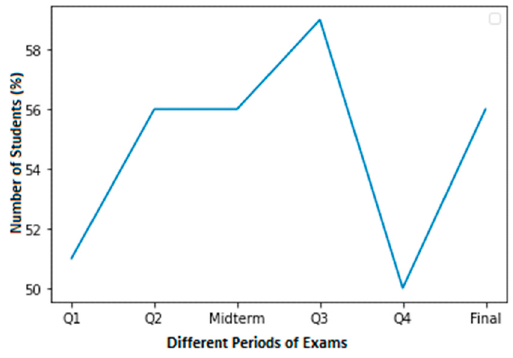
Figure 2. A high cheating dataset of student 1 with normal